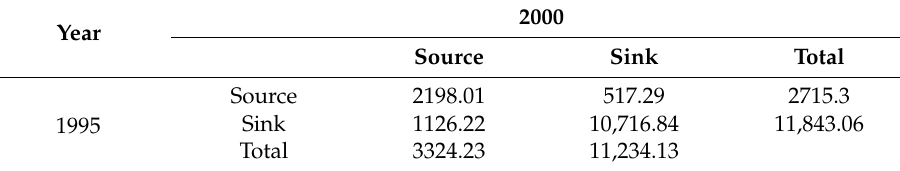
Table 25. The source-sink landscape transition matrix from 1995 to 2000 (km 2 ).